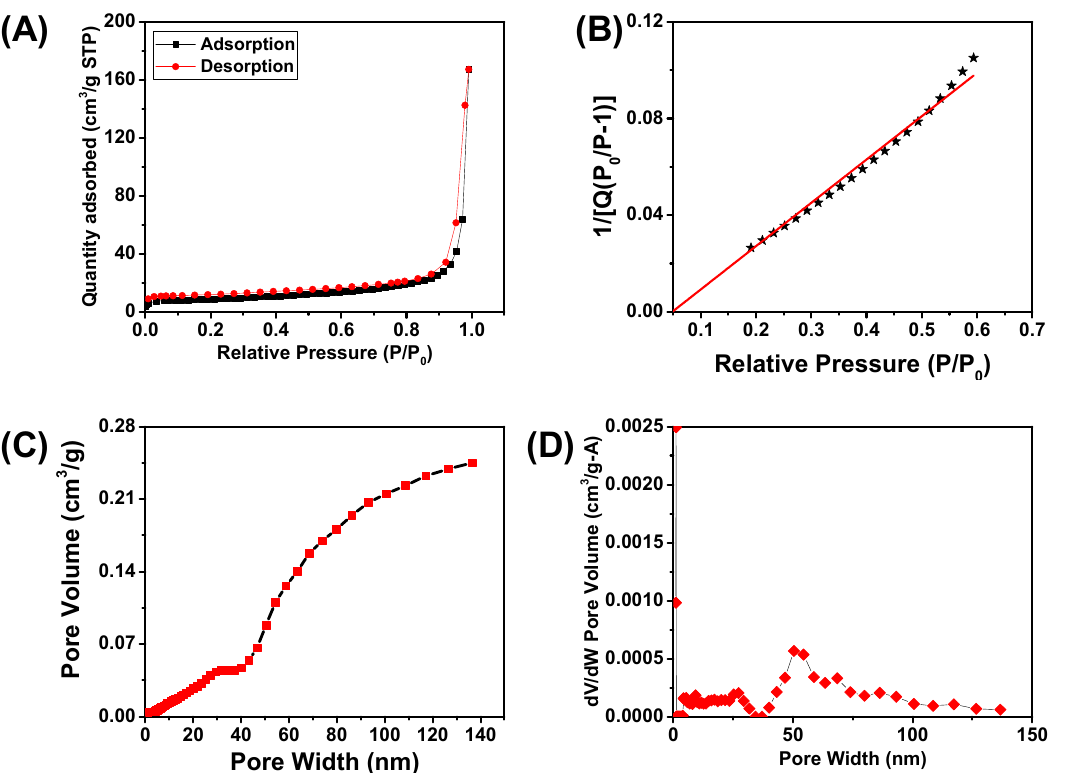
Figure 9. BET surface analysis with N 2 gas adsorption–desorption isotherms of bio-reduced CuO NPs ( A ), surface area plot ( B ), BJH desorption pore size distribution ( C ), and differential pore volume plot ( D ).